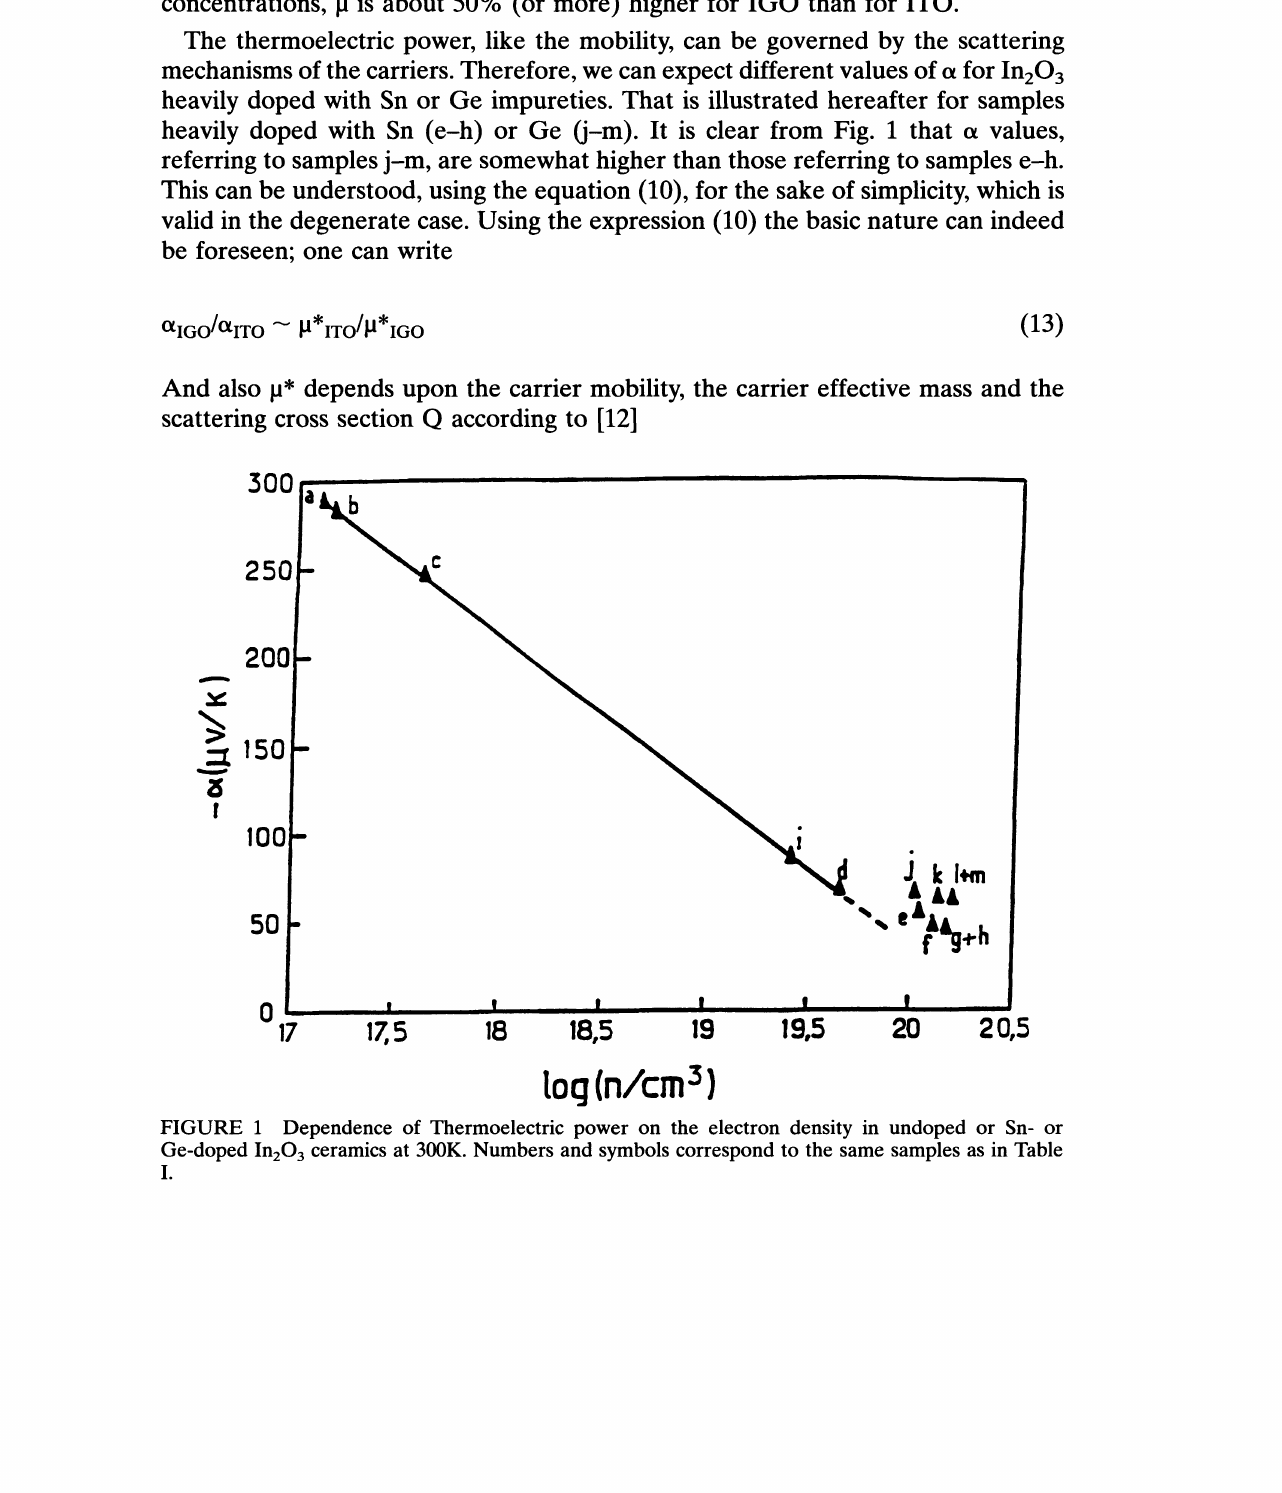
FIGURE 1 Dependence of Thermoelectric power on the electron density in undoped or Sn- or Ge-doped In203 ceramics at 300K. Numbers and symbols correspond to the same samples as in Table